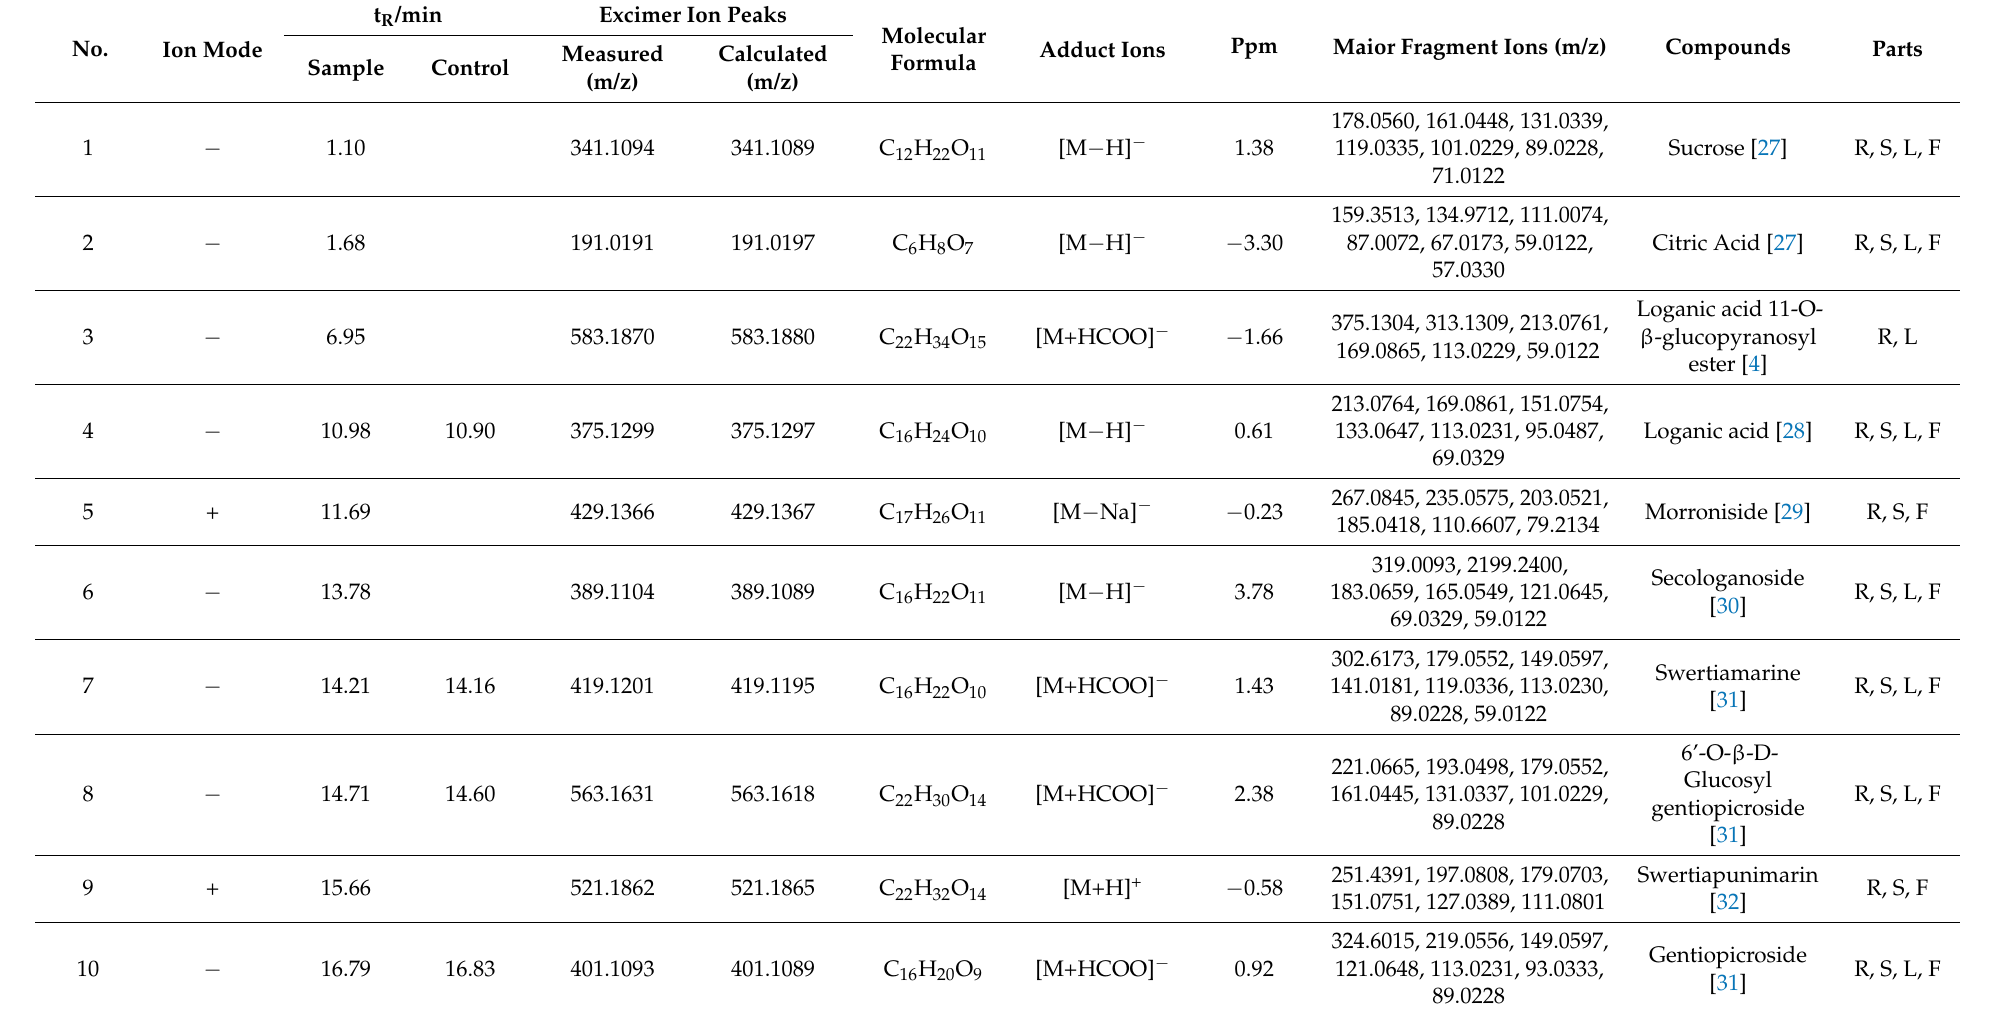
Table 2. Compounds identified in G. macrophylla by UPLC-Q-Exactive